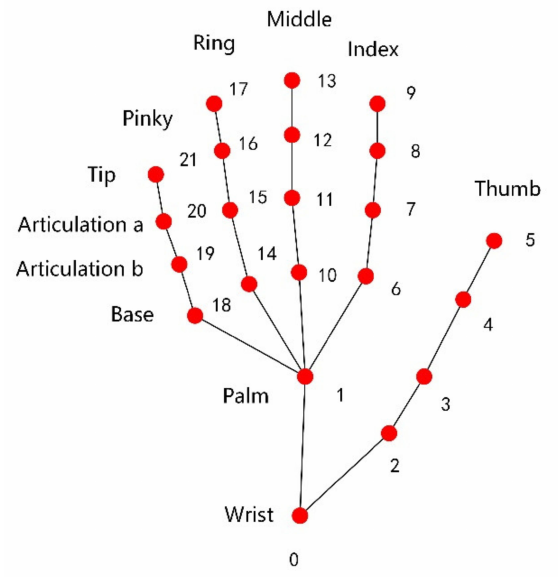
Figure 1. Location of key points in DHG-14/28.